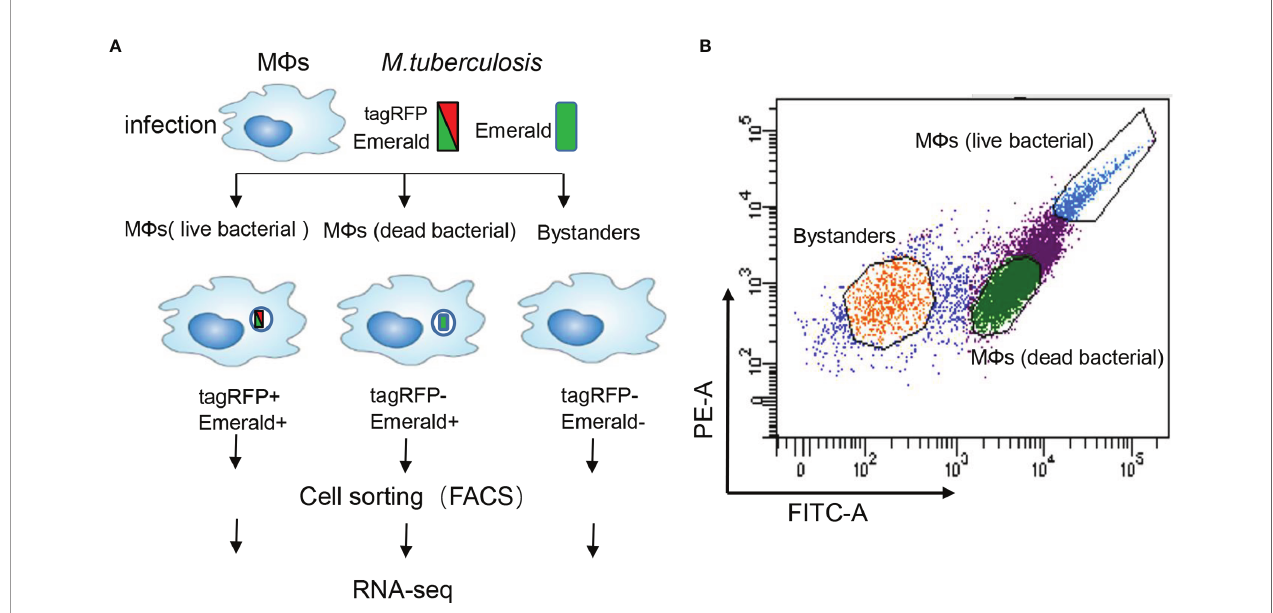
FIGURE 1 | Experimental strategy to sort human MDM with different bacterial content. (A) Schematic representation of the work fl ow. Human monocytes were differentiated with GM-CSF (20 ng/ml) for 6 days towards M0 GM-CSF MDM (brie fl y “ MDM ” ). These MDM were then infected with the M.tb strain H37Ra (MOI =10) harboring a dual-color reporter that comprises a constitutively (Emerald, green) and an anhydrotetracycline-inducible (tag-RFP, red) fl uorescent protein: the constitutive Emerald fl uorophore indicating total bacterial burden, and a tagRFP-positive for detection of live bacteria in MDM. After 6 h exposure of MDM, the bacteria were washed away, and MDM were cultured for another 72h. A heterogeneous population of MDM is detectable that consists of cells with live bacteria (left), cells with dead bacteria (middle), and uninfected bystanders (right). (B) Representative scatter plots of the infected MDM. The yellow gate captures bystanders, green gate captures MDM with dead bacteria, and blue gate captures MDM with live